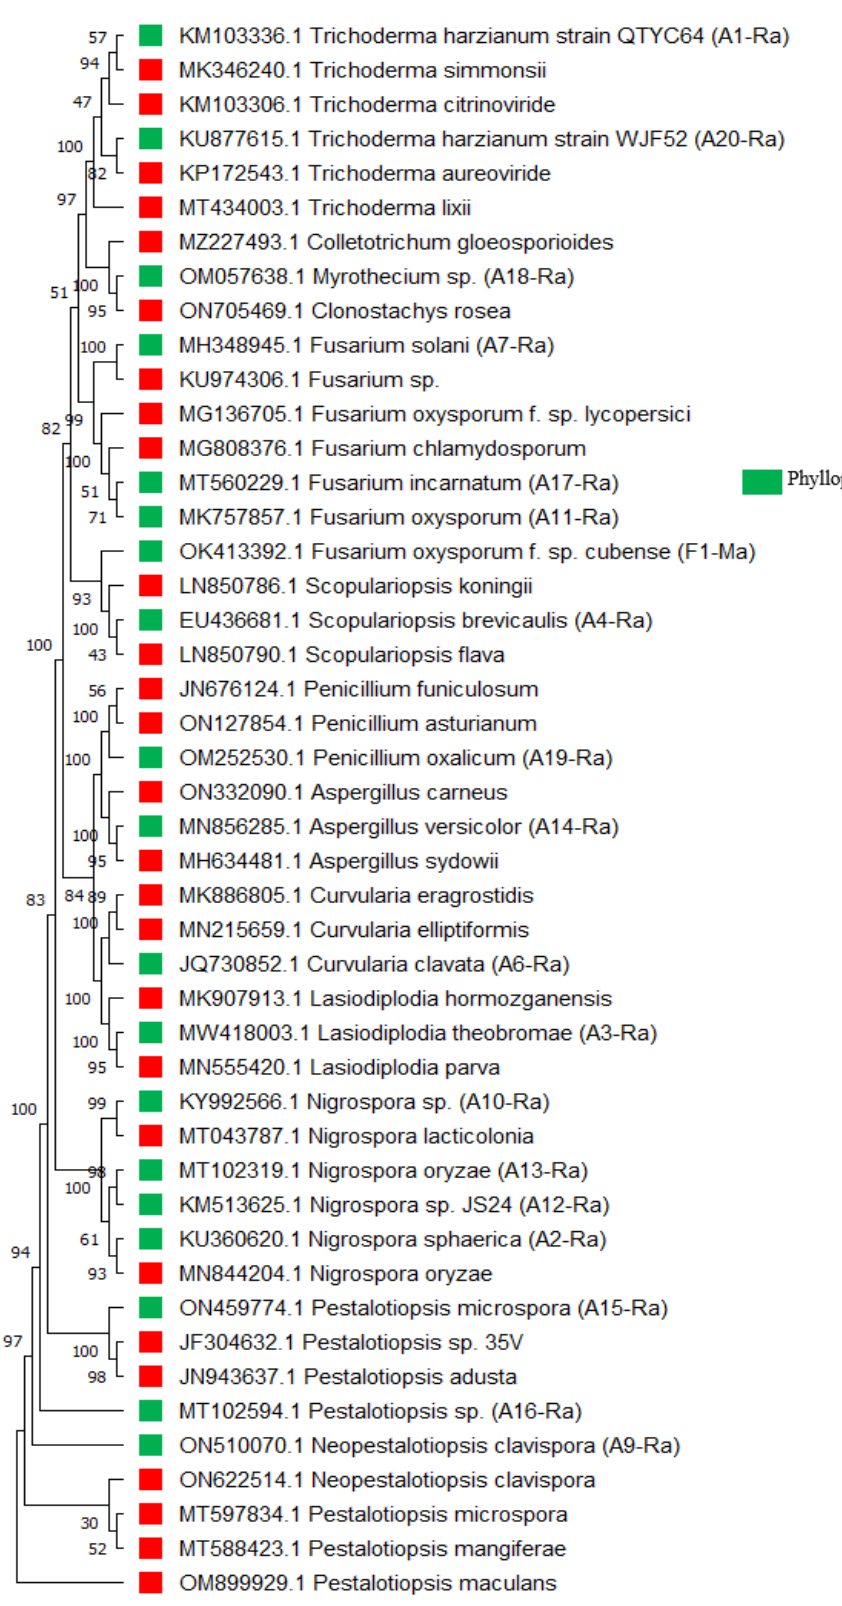
Figure 3. Phylogenetic tree of phylloplane fungi.